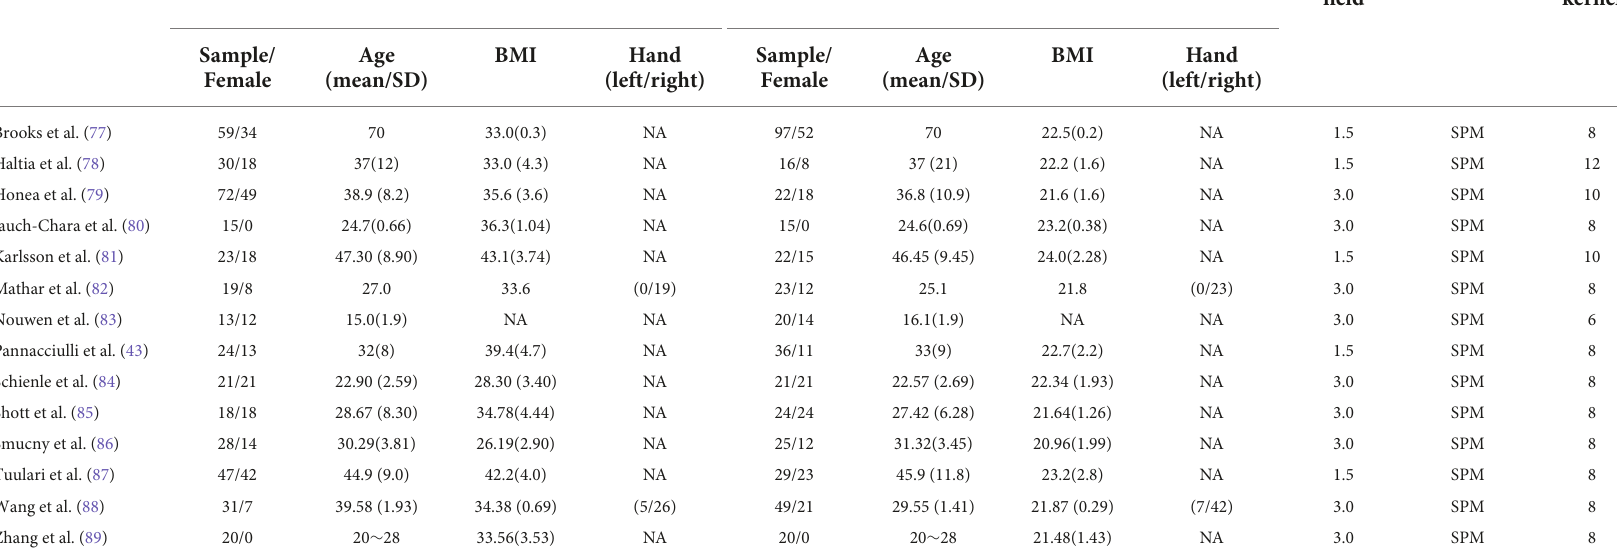
Software Smooth field